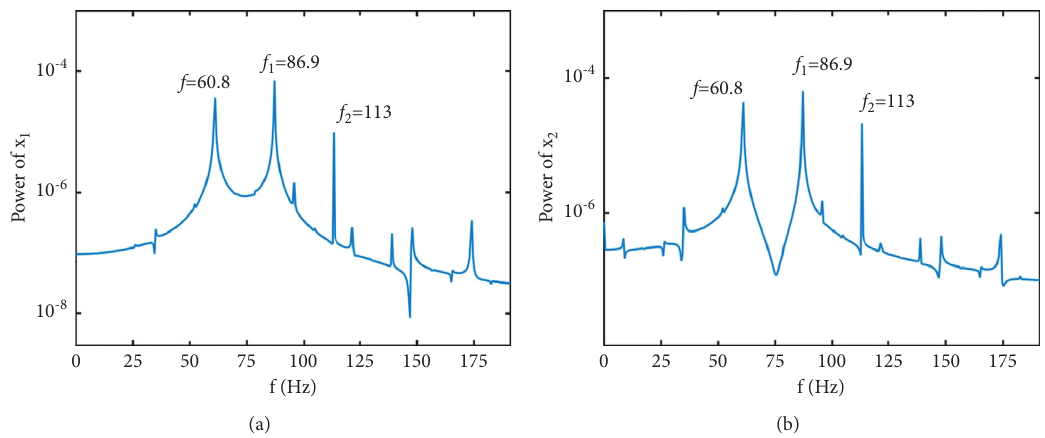
Figure 7: Spectrum of responses when combination frequency resonance occurs. (a) Low-pressure rotor and (b) high-pressure rotor.